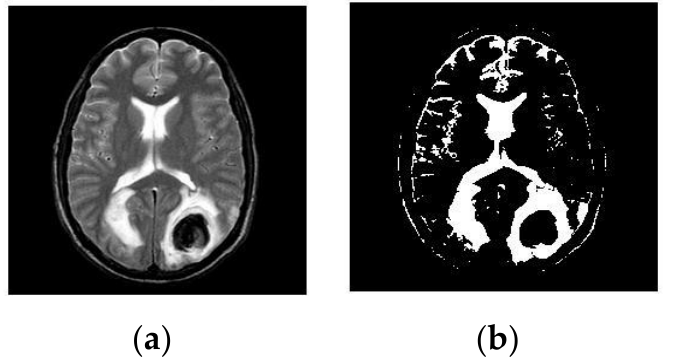
Figure 3. Here, image ( a ) is an input T-2 brain MRI image, whereas ( b ) is a segmented T-2 image. It is a Malignant Tumor according to the segmented picture.